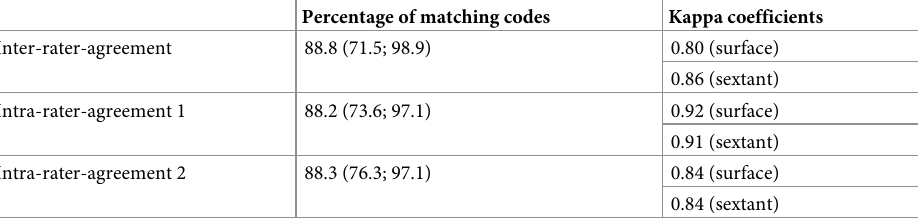
Table 1. Kappa coefficients and percentage of matching codes for areas (median (min;